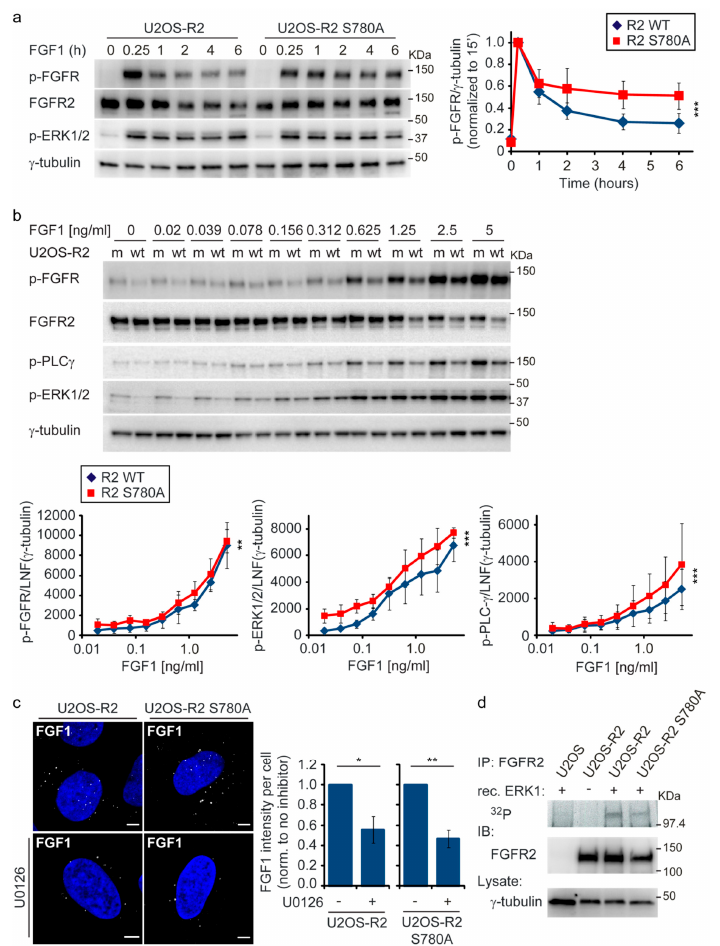
Figure 4. Signaling from FGFR2 S780A is prolonged compared to wild-type FGFR2. ( a ) U2OS-R2 wild-type or U2OS-R2 S780A cells were kept for two hours in serum-free media before addition of 100 ng / mL FGF1 and heparin (20 U / mL) for the indicated periods of time. Cycloheximide (10 µ g / mL) was added at the beginning of the starvation period and kept throughout the experiment. After lysis, the cellular material was analyzed by immunoblotting using the indicated antibodies. A p in front of the name of the antibody indicates that it recognizes the phosphorylated form of the protein. Quantifications of five independent experiments are presented in the graph. The bands corresponding to phosphorylated receptor were normalized to γ -tubulin and within each experiment to the time point of 15 min. Error bars denote the standard deviation. The difference between FGFR2 wild-type and the S780A mutant was significant ( p ≤ 0.001, 3-way ANOVA, Holm-Sidak test, n = 5). ( b ) U2OS-R2 wild-type (wt) or U2OS-R2 S780A (m) cells were kept for two hours in serum-free media before addition of indicated concentrations of FGF1 in the presence of heparin (20 U / mL) for 15 min. After lysis, the cellular material was analyzed by immunoblotting using the indicated antibodies. A p in front of the name of the antibody indicates that it recognizes the phosphorylated form of the protein. Quantifications of three independent experiments are presented in the graph. The bands corresponding to the phosphorylated receptor / ERK1 / 2 / PLC γ were normalized to LNF ( γ -tubulin). Error bars denote the standard deviation. The difference between FGFR2 wild-type and S780A mutant was significant (** p ≤ 0.01, *** p ≤ 0.001, 3-way ANOVA, Holm-Sidak test, n = 3). ( c ) Internalization of DL550-FGF1 in FGFR2 and FGFR2 S780A cells is reduced upon U0126 treatment. U2OS-R2 and U2OS-R2 S780A cells were incubated with 200 ng / mL DL550-FGF1 and heparin (50 U / mL) for 30 min. The cells were pretreated as indicated with U0126 (20 µ M) for 30 min before addition of